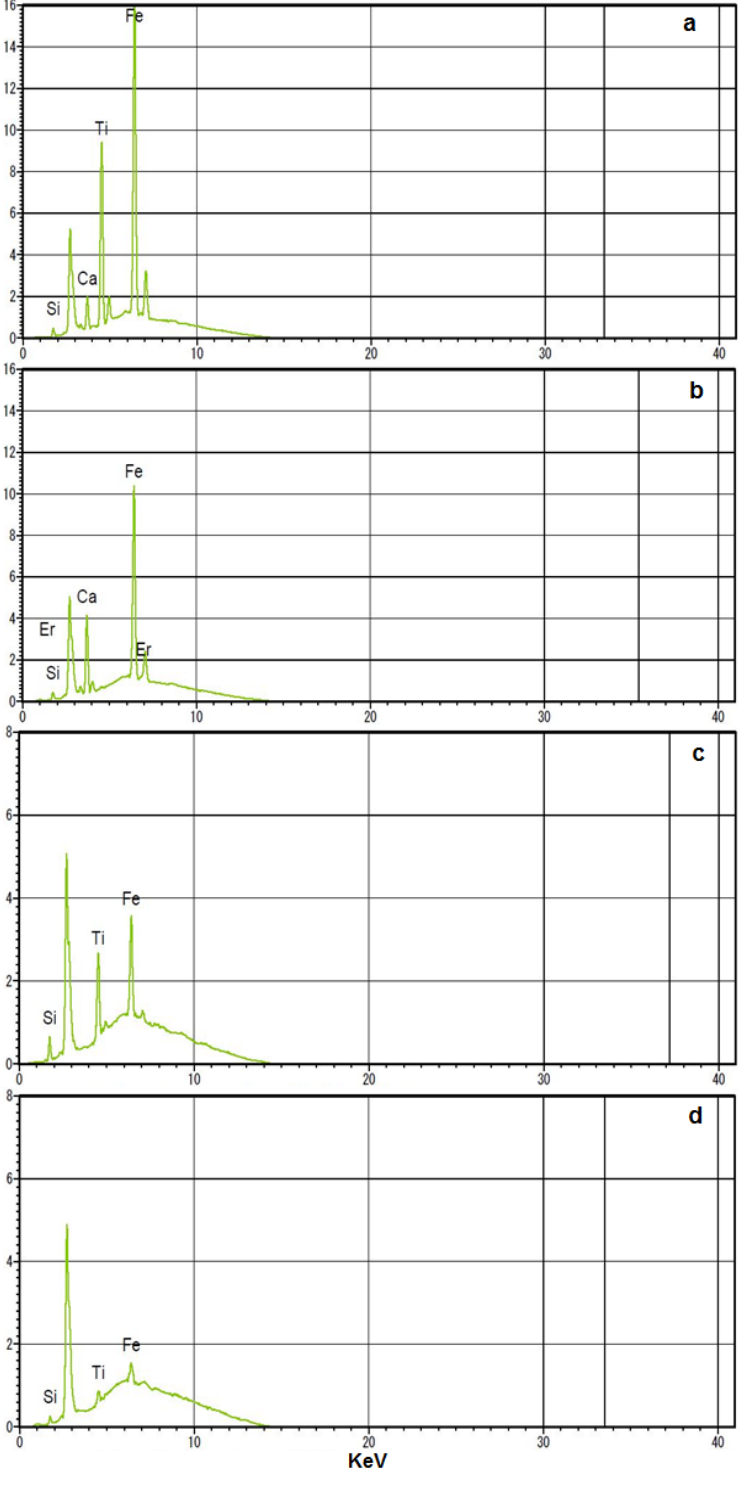
Figure 9. XRF analysis of ( a ) river sand, ( b ) M sand, ( c ) fine silica sand, and ( d ) coarse silica sand.